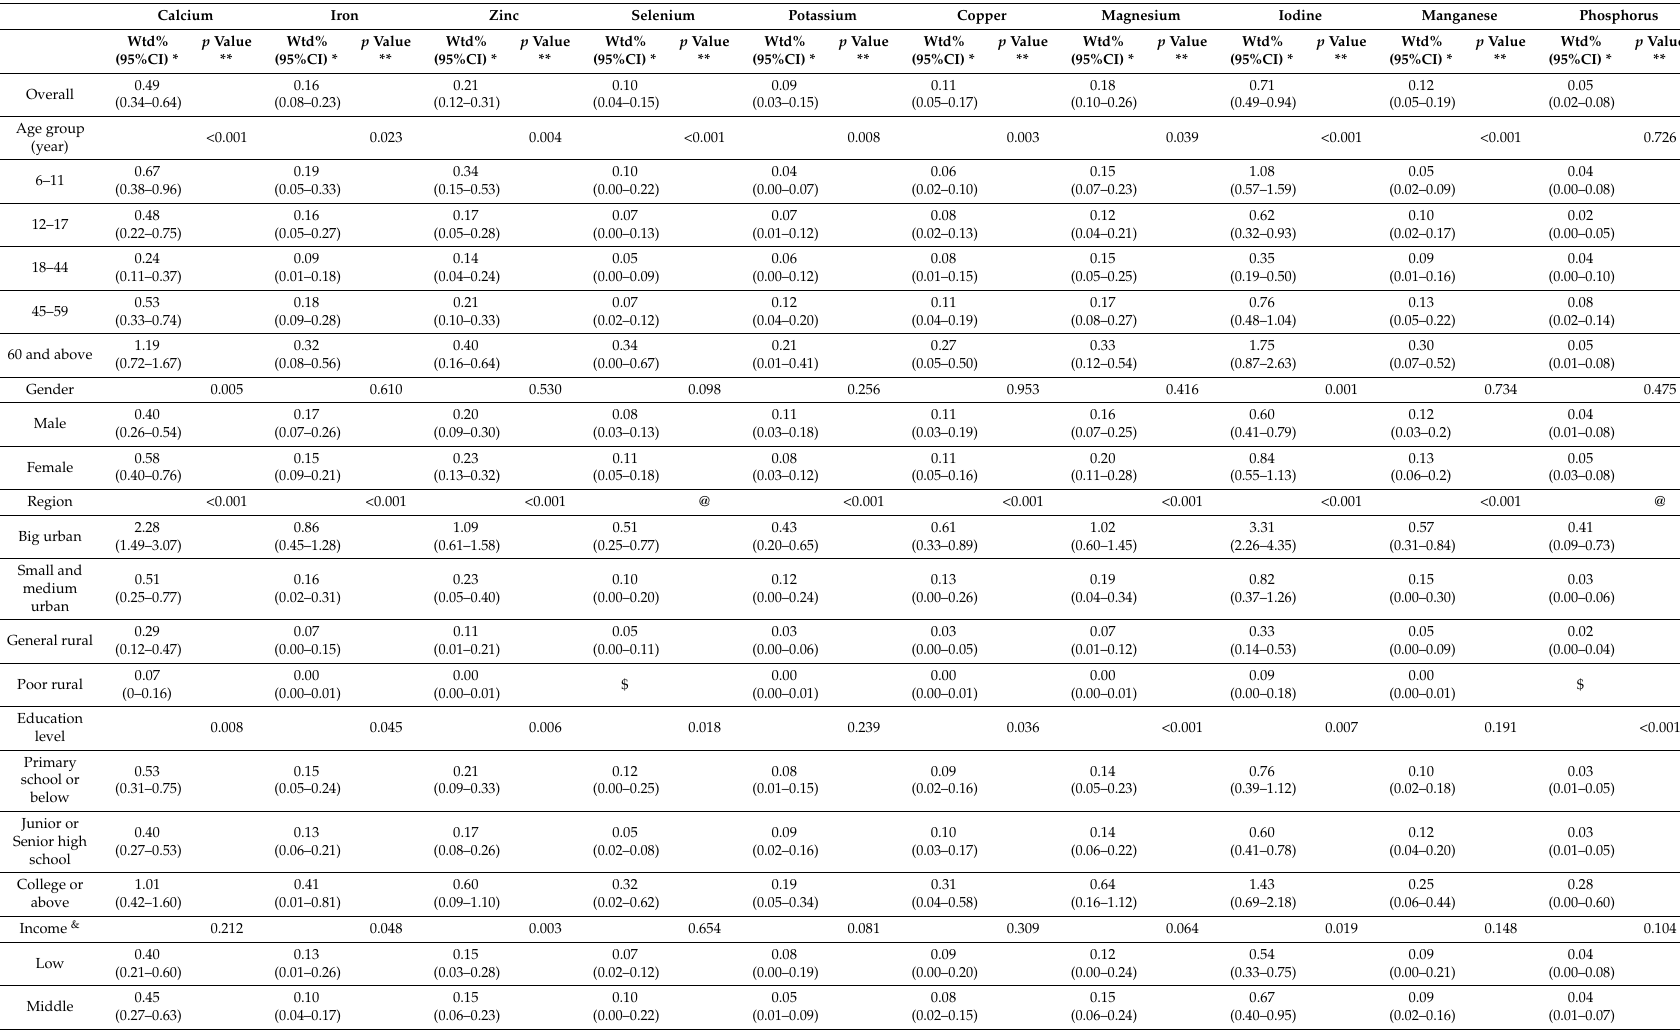
Table 3. The minerals supplemented among the Chinese population aged 6 years and above in 2010–2012